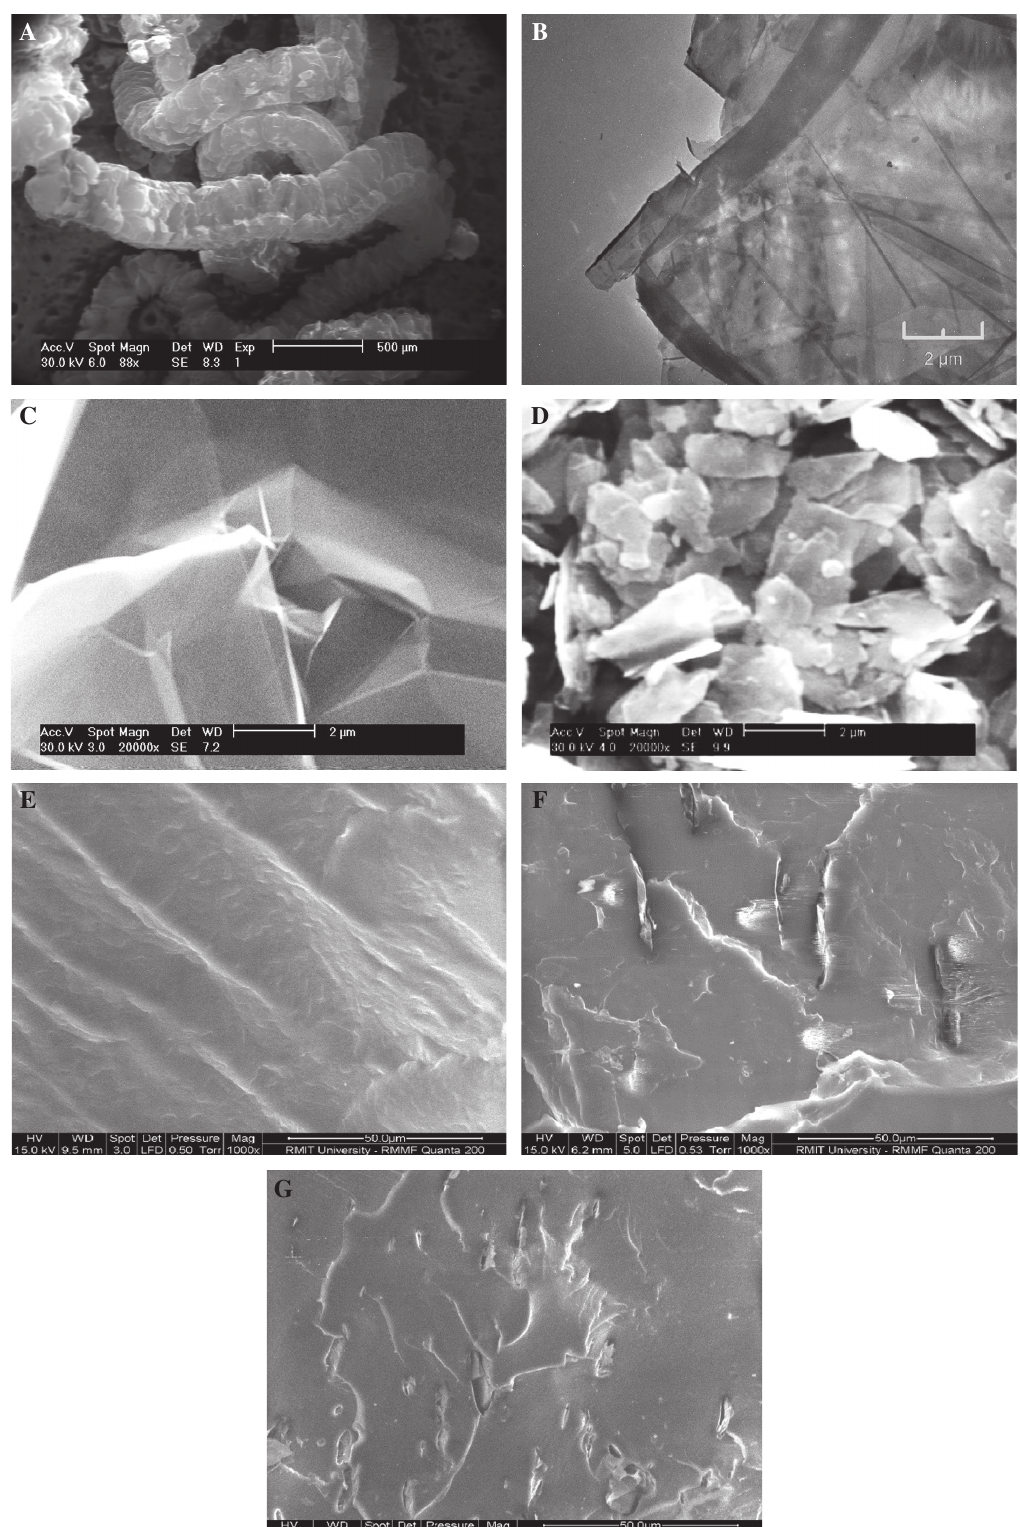
500 μ m 80 × showing worm/accordion-like expansion 20,000 × (2 μ m), (B) TEM image of GT 1000 ° C 30 s Figure 2 SEM image of (A) GT N 2 with ultrasonication, and SEM images of (C) GT N (inert gas to remove oxides), (D) CT#1 > 700 m 2 /g and 1000 × , (E) SBS neat, (f) SBS-1000 ° C 2 30 s, and (g) SBS-H reduced 2